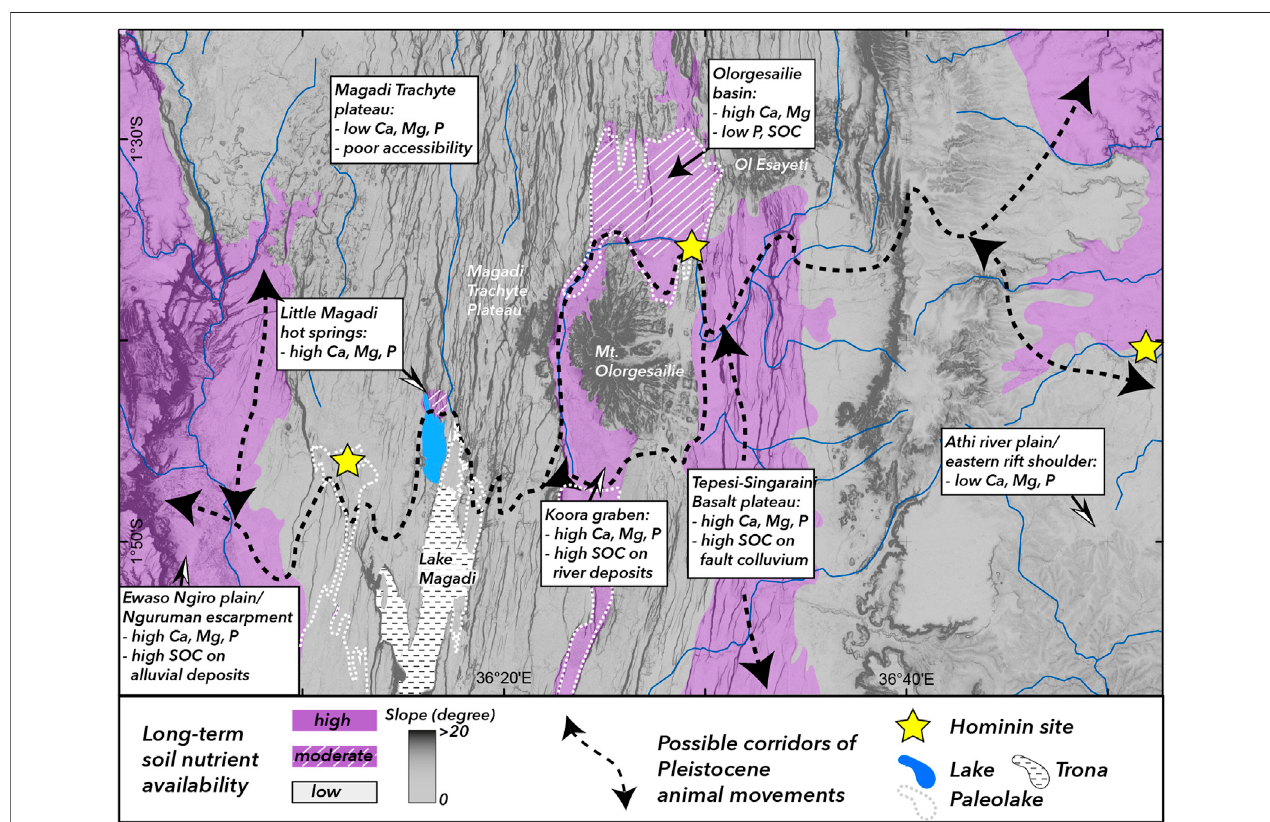
FIGURE 9 | Soil nutritional corridors and Pleistocene human-animal-landscape interactions. Regions colored in gray are characterized by low long-term soil nutrient availabilityand/orpooraccessibilityduetotopographicbarrierssuchasfaultscarpsandcomplexterrain,purpleregionsrepresentpossiblesoilnutritionalcorridorsandpaleo- migration routes for animal herds that could have been exploited by early hominins. Purple regions with white cross patterns depict regions of moderate nutrient availability (e.g., high Ca, but low P or SOC) potentially representing locations of transitional or short-term grazing. Steep slopes are potential migration barriers in regions of high landscape complexity and are indicated by dark gray shading. Yellow stars indicate locations of hominin fossil sites: (I) Isinya, (L) Lainyamok, (O) Olorgesaile. Potential paleolake extents (dashed white lines) are derived from geological and pealeoenvironmetal datasets (Guth and Wood, 2013; Muiruri, 2017; Owen et al., 2019).